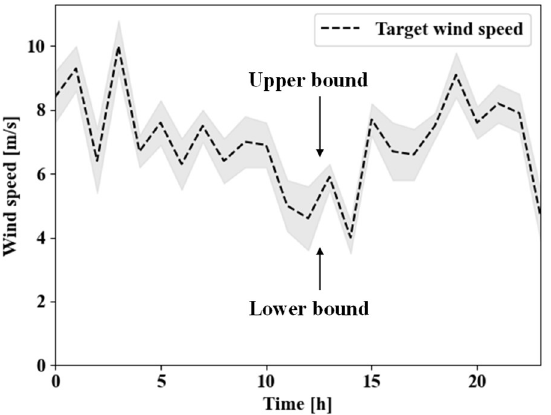
Figure 2. Wind speed in Aewol-eup considering uncertainty of wind speed data.